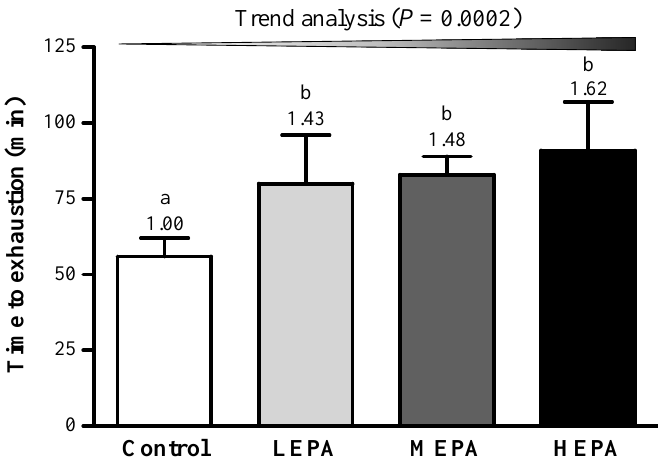
Figure 2. Effect of EPA on endurance time to exhaustion of rats. LEPA: low dose (75 mg/kg); MEPA: medium dose (150 mg/kg); HEPA: high dose (375 mg/kg). Data are mean ± SD ( n = 6 rats per group). Different letters (a, b) indicate significant difference at p < 0.05 by the Cochran-Armitage test for dose-effect